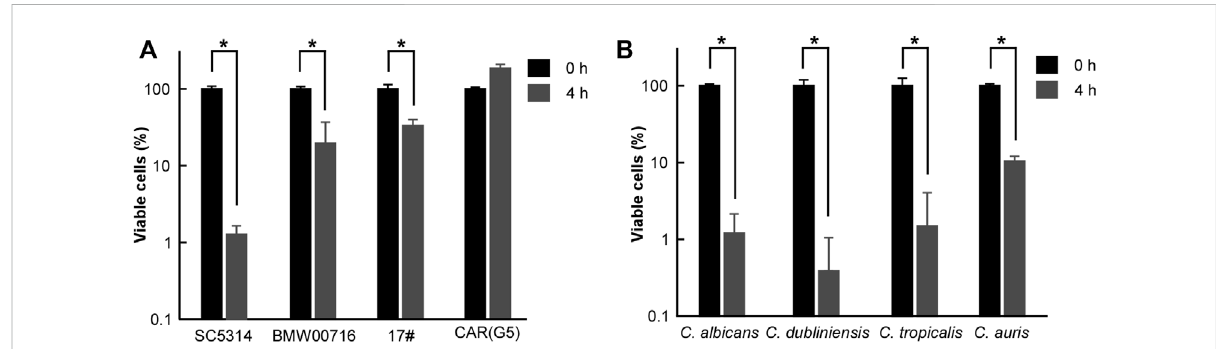
FIGURE 3 Antifungal effects of CHGX water-extract on azole-resistant strains of C. albicans , and other clinical fungal species. Cells of azole-resistant strains (A) orclinicalstrains (B) of C.albicans (P37005), C.dubliniensis (D173), C.tropicalis (JX1002), C.auris (BJCA001)wereinitiallyculturedinliquid YPD medium atlogarithmicphase, and werethenharvested,washed, andre-suspended inliquidLee ’ sglucose medium for atime-killkinetics assay. Fungal cells (2 × 10 5 cells/ml) were treated with 20 mg/ml GHGX water-extract for 0 h and 4 h at 30 ° C in Lee ’ s glucose medium, and the percentageofviablecellswasdeterminedusingplatingassays.Threebiologicalrepeatswereperformed,andthevaluesarepresentedasmean±SD. One-way analysis of variance (ANOVA) was employed to compare differences between 0 and 4 h as indicated; *, p <